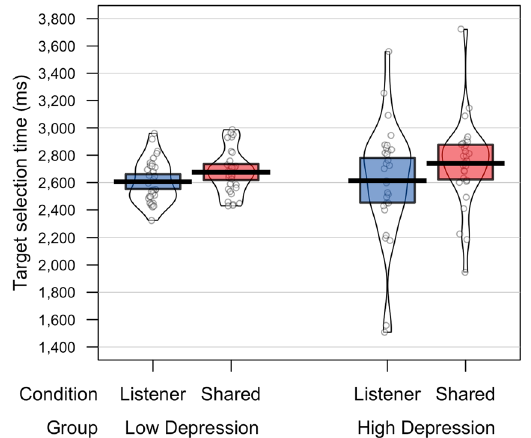
Figure 2. Target selection response times on the perspective-taking task, for each condition and depression group.